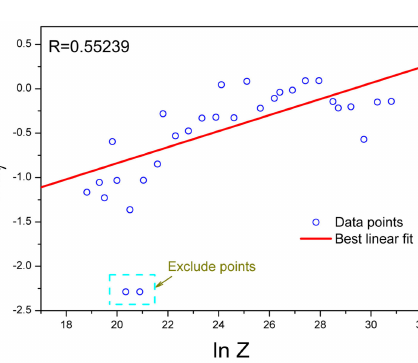
Figure 5. Relation between the material constant, c 1 , and the Zener-Hollomon